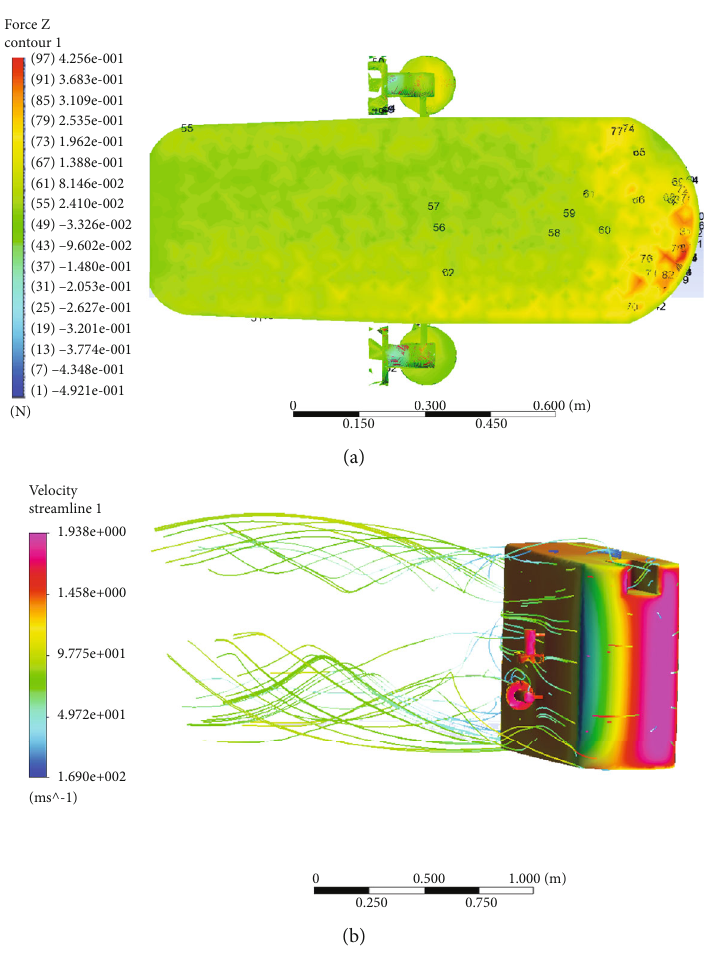
Figure 5: Contour and velocity streamline: (a) force Z contour; (b) velocity stream line.